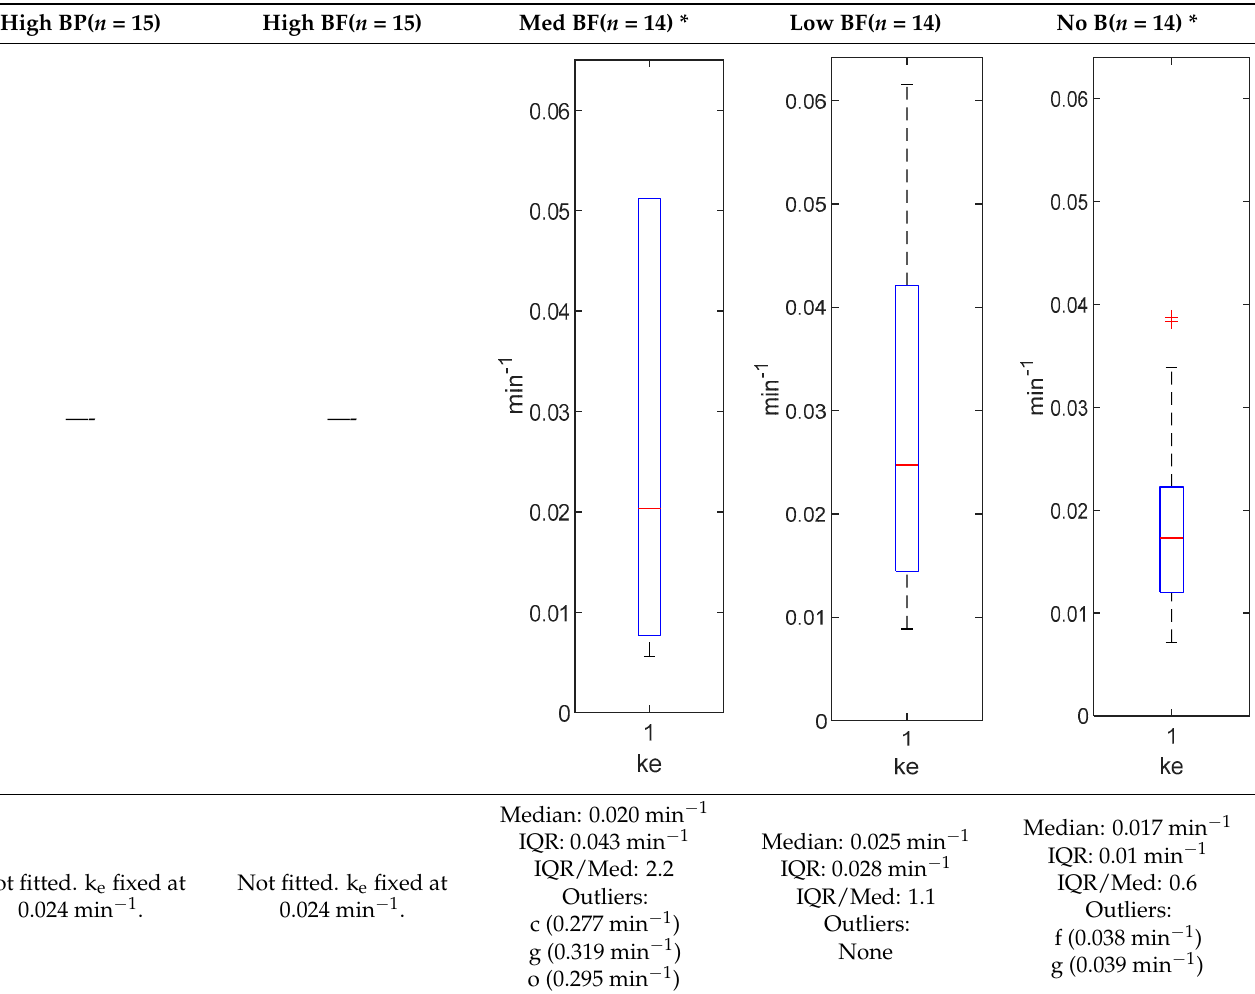
Table A4. k e estimation results.